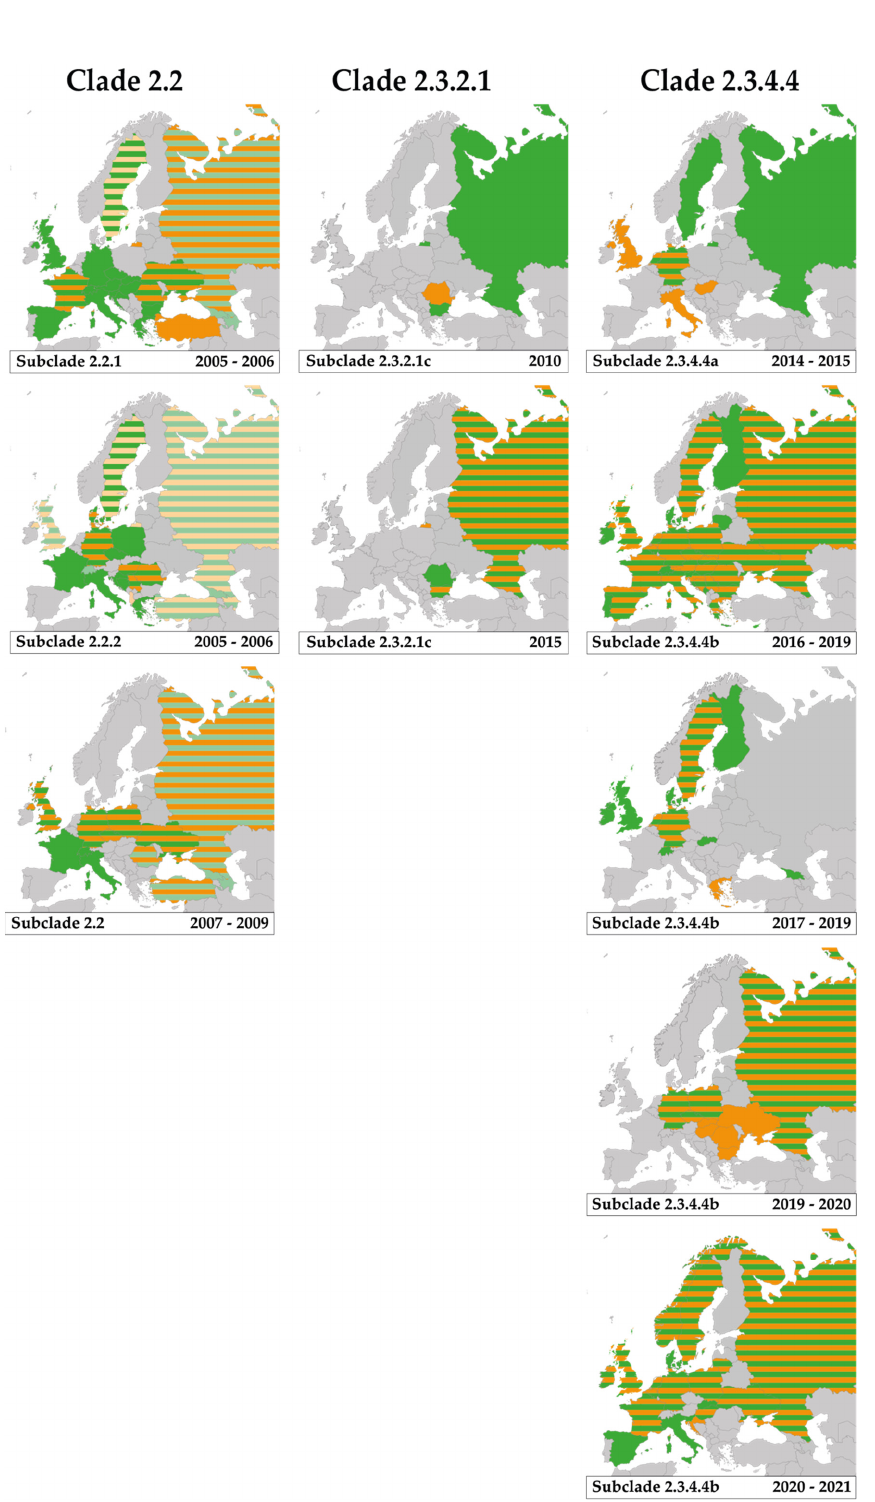
Figure 1. Highly pathogenic avian influenza H5 GsGd virus detections in wild birds and poultry in Europe, 2005–2020. Each panel shows the European countries in which the subclade had been detected, including the time period. Green, viruses detected in wild birds; orange, viruses detected in poultry; green-orange striped pattern, subclade detected in both wild birds and poultry at country level; light green, clade 2.2 viruses detected in wild birds and subclade unknown; light orange, clade 2.2 viruses detected in poultry and subclade unknown. References used